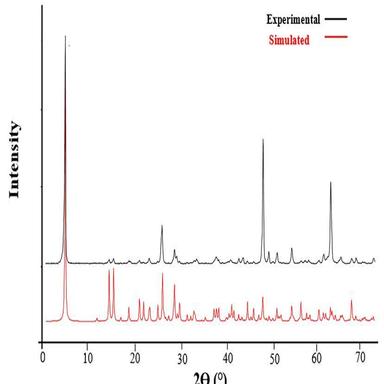
Experimental (in black) and simulated (in red) powder XRD patterns of the compound(C8H12N)42.